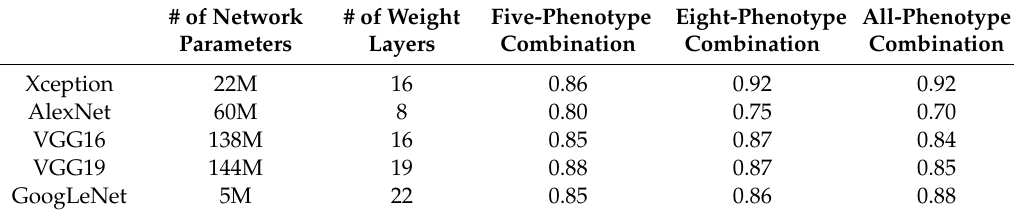
Table 3. Comparison of classification accuracy between our Xception-based method with Tyagi’s